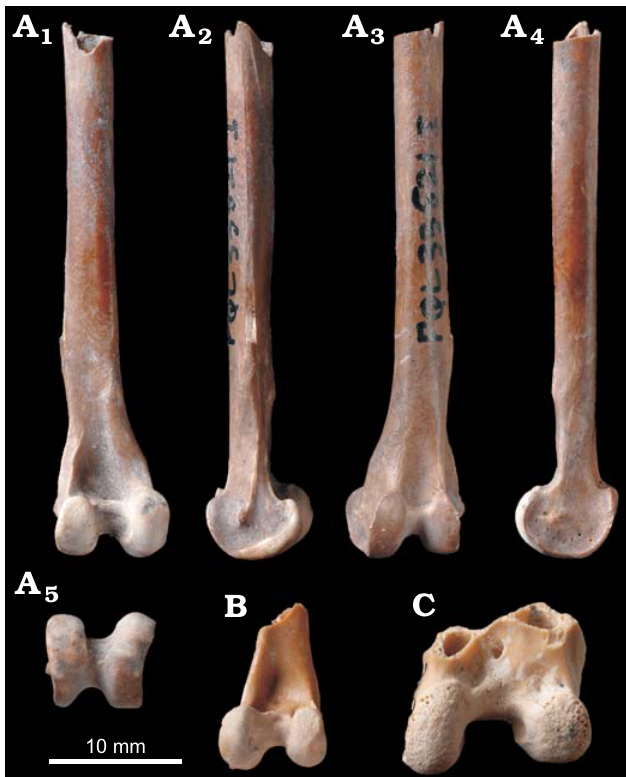
Fig. 3. Strigid owls from the early Pliocene, Upper Varswater Formation at Langebaanweg, South Africa. A . Asio sp. (SAM-PQ-L33521 I), right tibiotarsus, in cranial (A ), lateral (A ), caudal (A ), medial (A ), and distal 1 2 3 4 (A ) views. B . Strigidae gen. et sp. indet. (SAM-PQ-L28479 C), left tibi- 5 otarsus in cranial view. C . Bubo sp. (SAM-PQ-L28439 C), left tibiotarsus in cranial